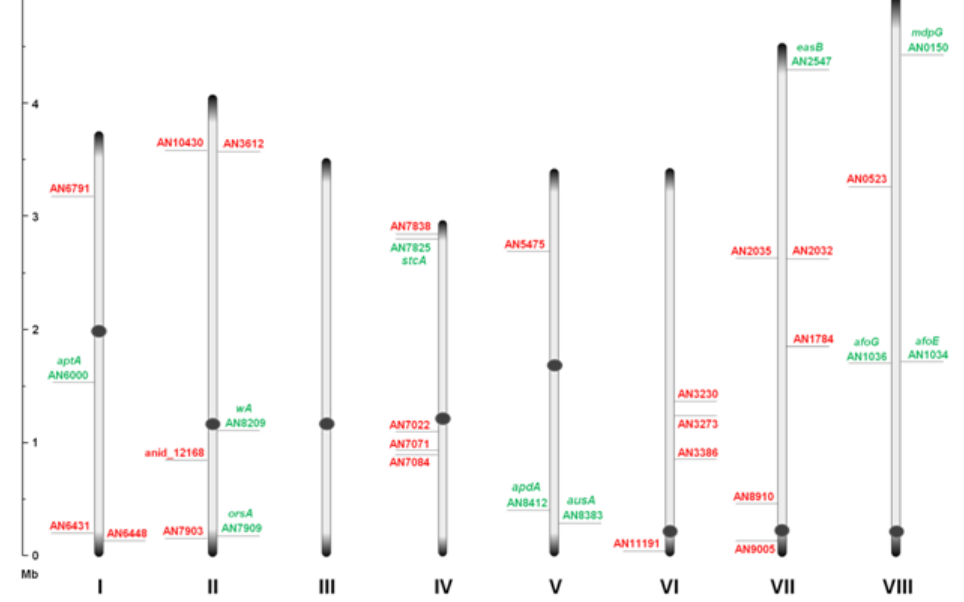
Figure 1. An overview of the relative distribution of the 32 putative polyketide synthases (PKS) open reading frames (ORFs) on the eight chromosomes of A. nidulans . Green and red AN numbers represent assigned and unassigned PKS genes, respectively. Dark grey circles and ends symbolize centromeric and telomeric regions, respectively, and should not be considered to